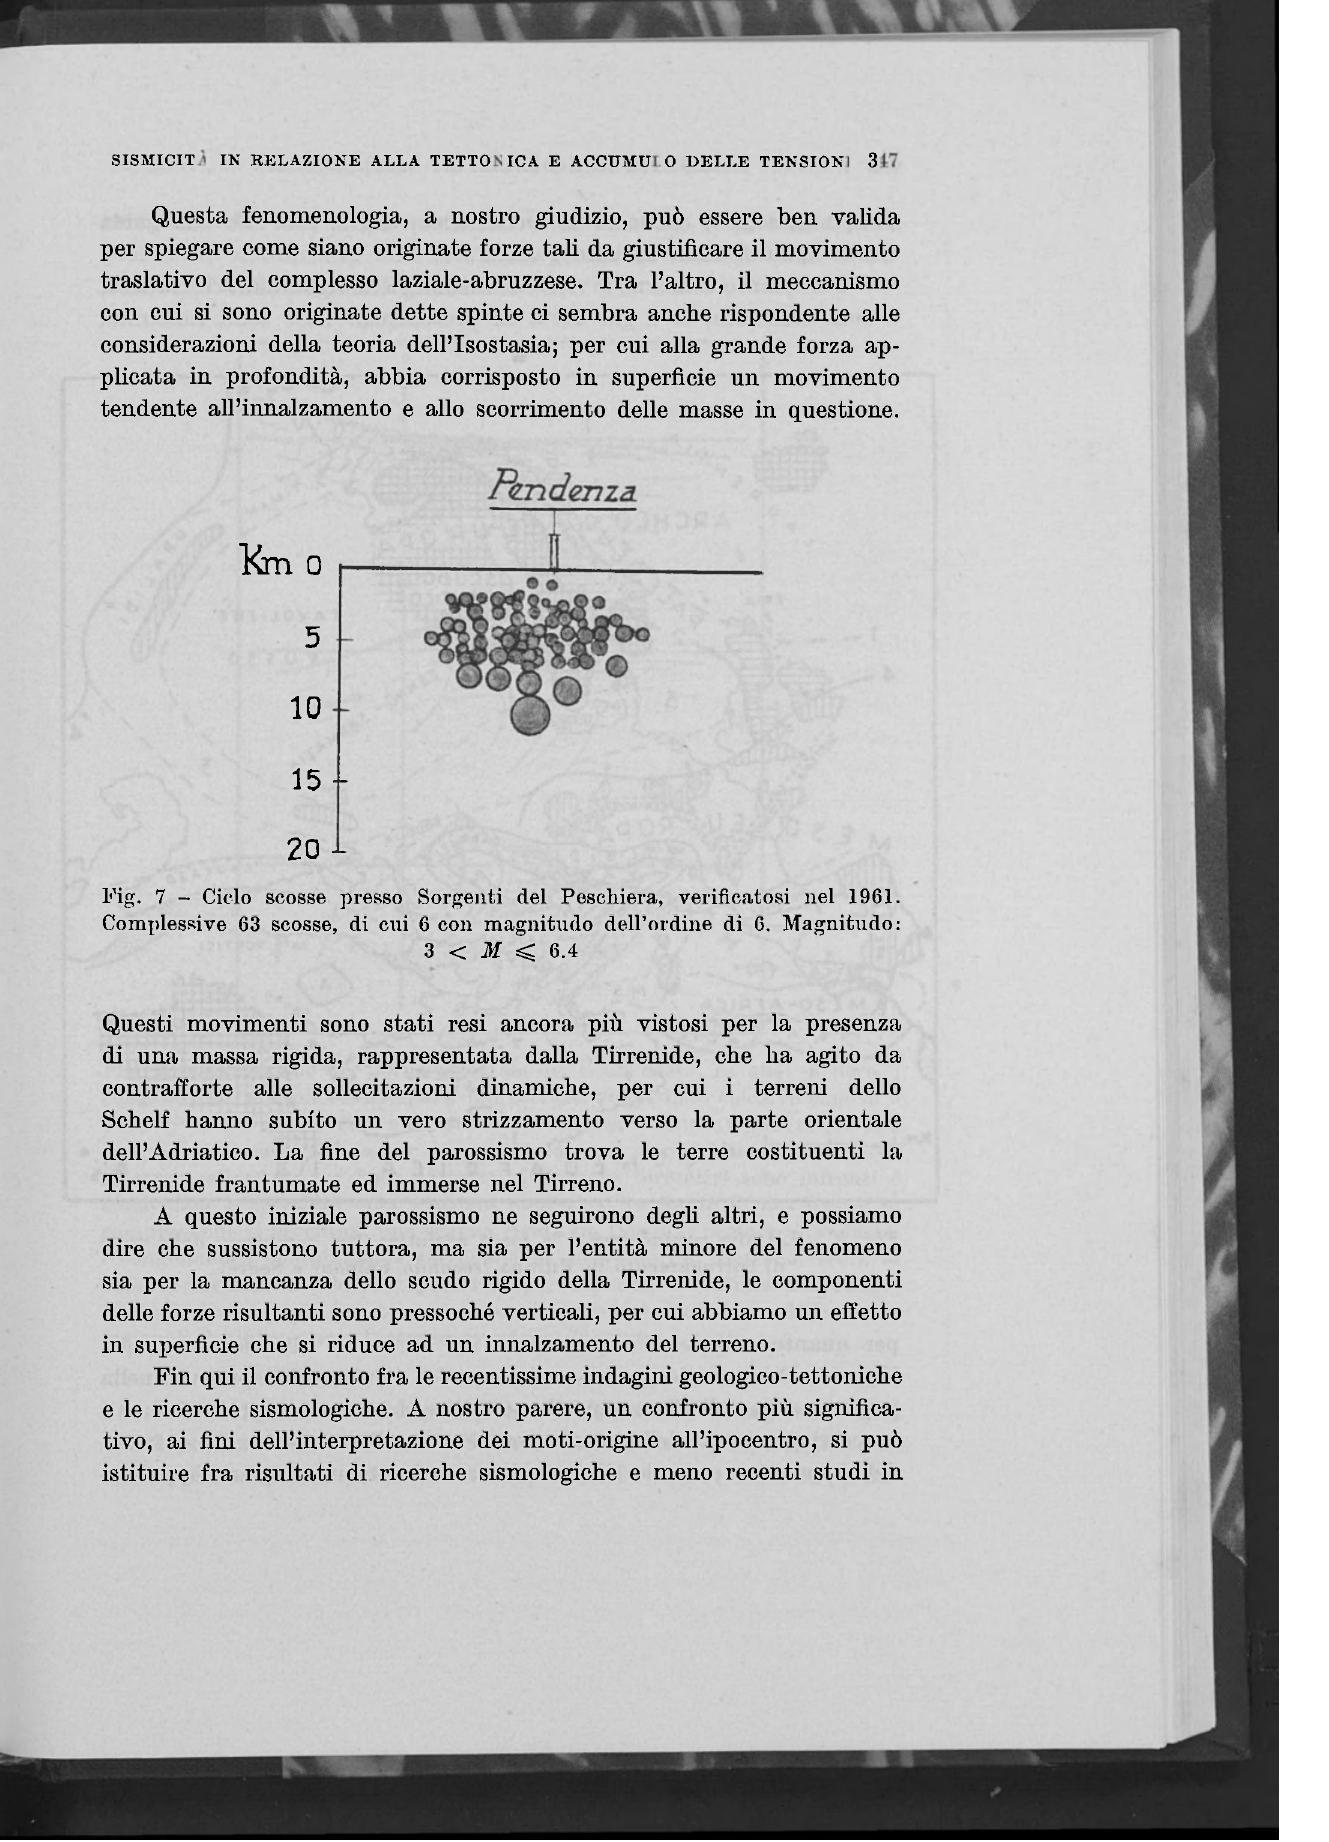
Fig. 7 - Ciclo scosse presso Sorgenti del Peschiera,, verificatosi nel 1961. Complessive 63 scosse, di cui 6 con magnitudo dell'ordine di 6. Magnitudo: 3 < M <